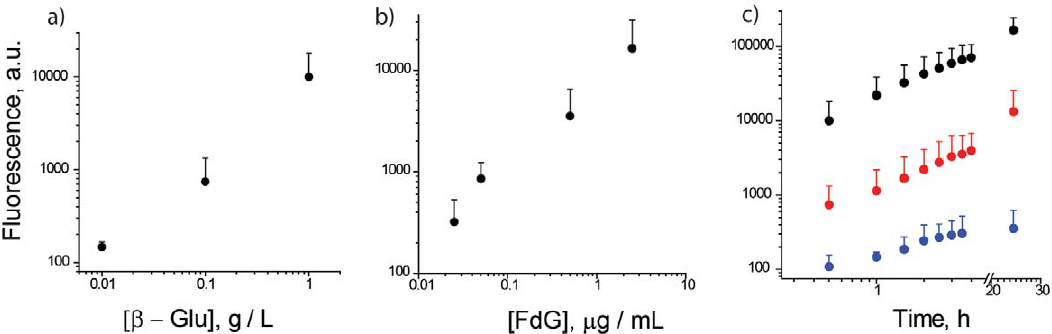
Figure 3. SMEPT offers several arms of control over the rate of generation and the overall amount of the product generated by the enzyme containing substrates: concentration of the enzyme in the gel (a), concentration of the added substrate (b) and time of enzymatic conversion (c). Experimental conditions: (a) FdG, 2,5 m g/mL, 30 min reaction time; (b): 1 g/L b -Glu in polymer solution, 30 min reaction time; c) FdG: 2,5 m g/mL; b -Glu: 1 (top), 0.1 (middle) and 0.01 (bottom) g/L, respectively. Presented results (mean 6 st.dev.) are average over at least 3 independent experiments, 3 replicates each.